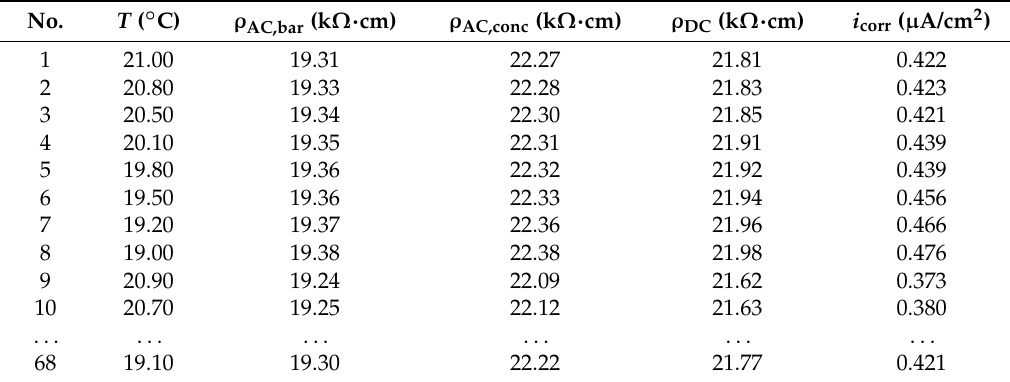
Table 1. Exemplary steel corrosion data with moderate corrosion rates [33].